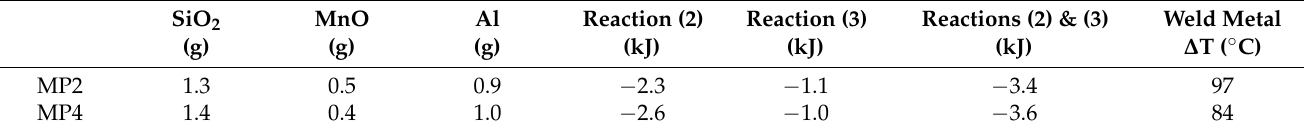
Table 7. Exothermic heat from reactions (2) and